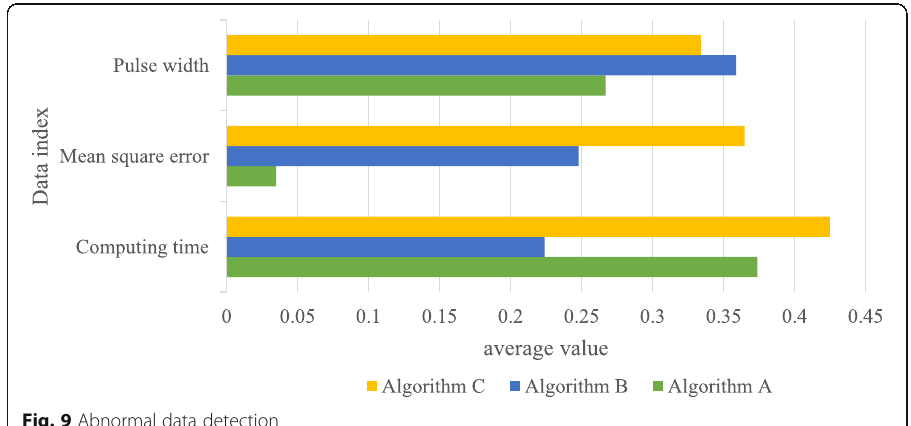
Fig. 9 Abnormal data